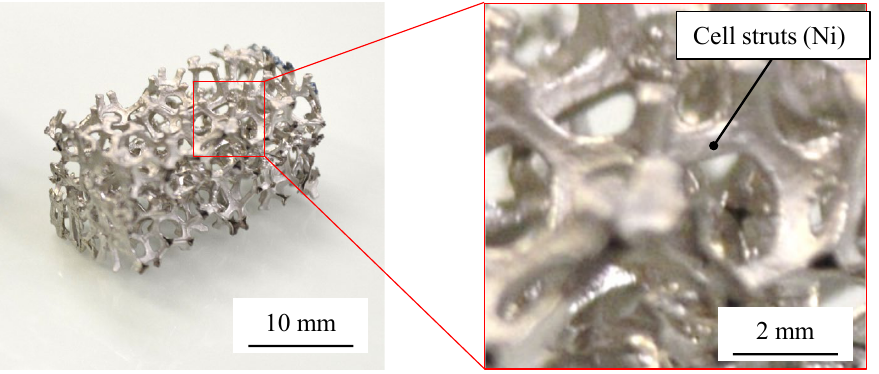
Figure 1. External view of foamed Ni.